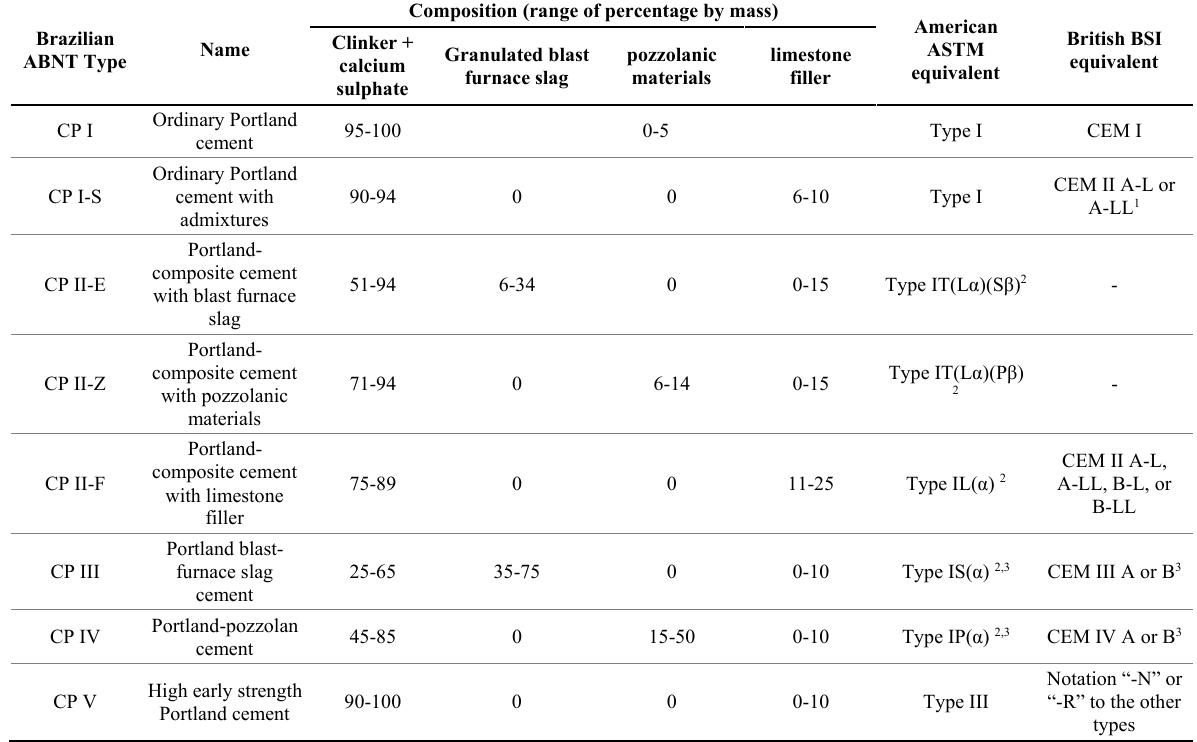
Table 1. Summary of current Brazilian cement types and their American and British equivalents [30]-[33]. Brazilian ABNT Type